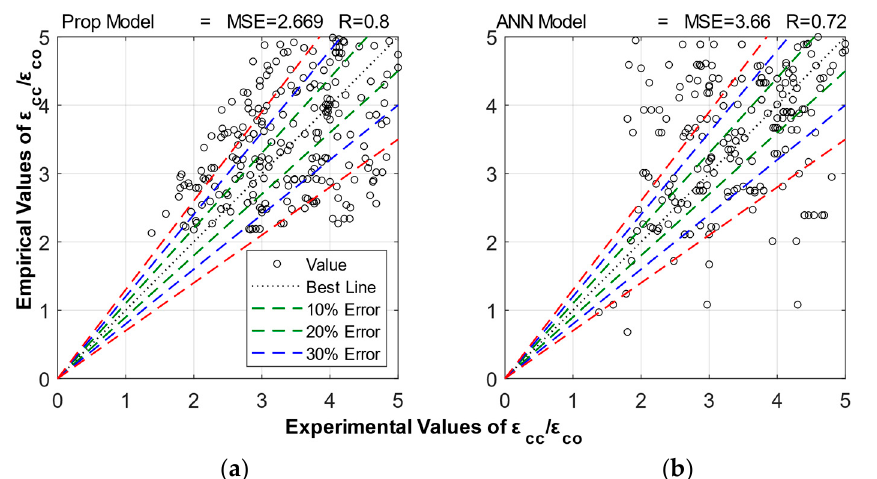
Figure 10. Performance for strain, for: ( a ) the proposed analytical model; ( b ) the corresponding ANN model).